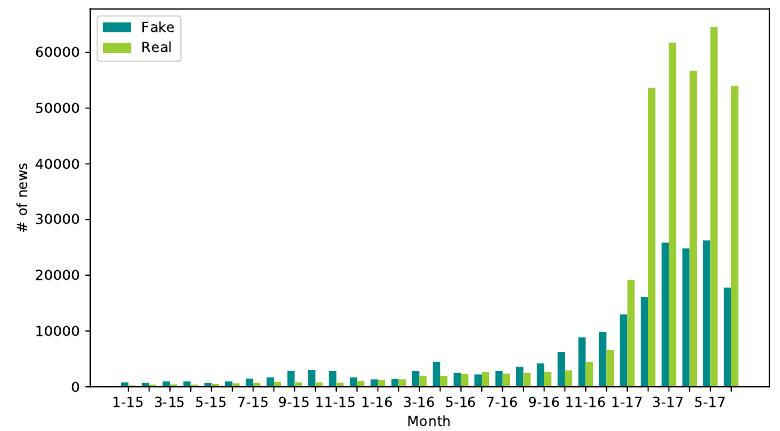
Figure 1. Distribution of tweets labeled as real and fake news in the training dataset.